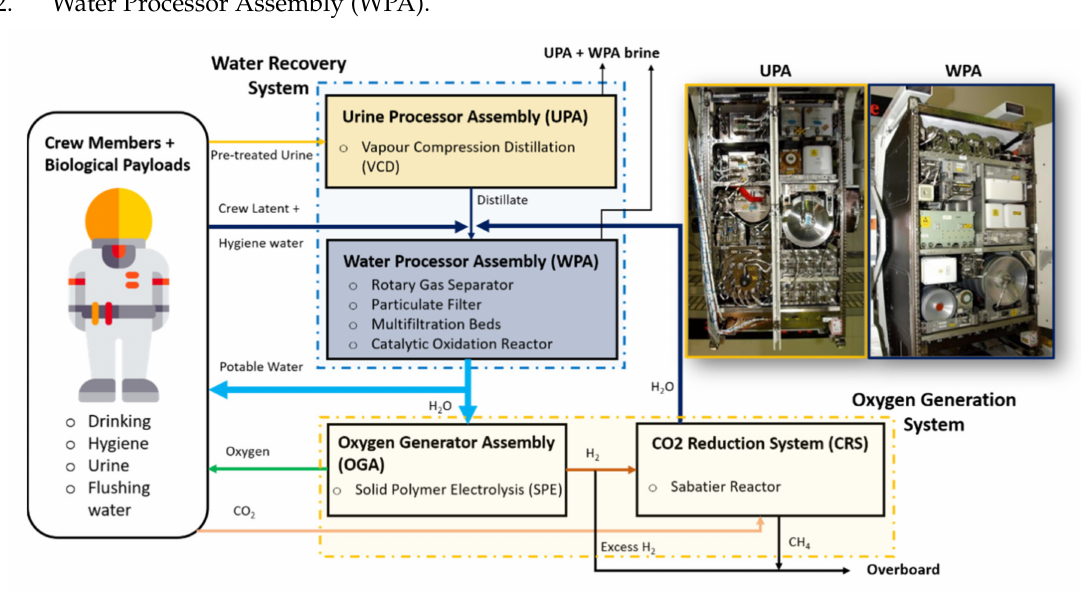
Figure 2. Schematic of the water recovery and management architecture for the US International Space Station (ISS) segment. Adopted and modified from